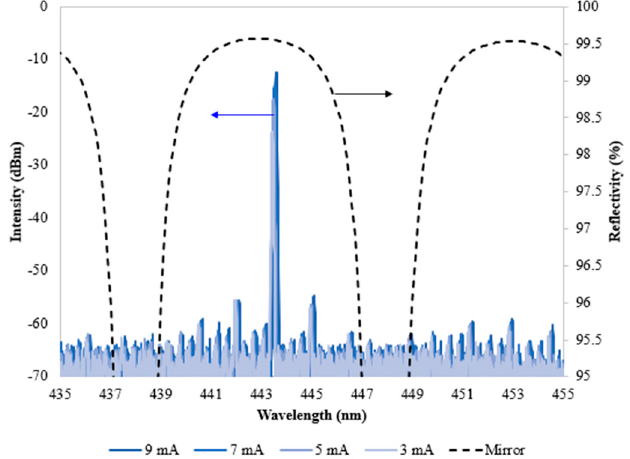
Figure 10. The emission spectrum of curved mirror VCSELs with a filtering mirror. The longitudinal modes are stable across multiple operating conditions regardless of the nanometer narrow mode spacing due to a long cavity that is >20 µm.